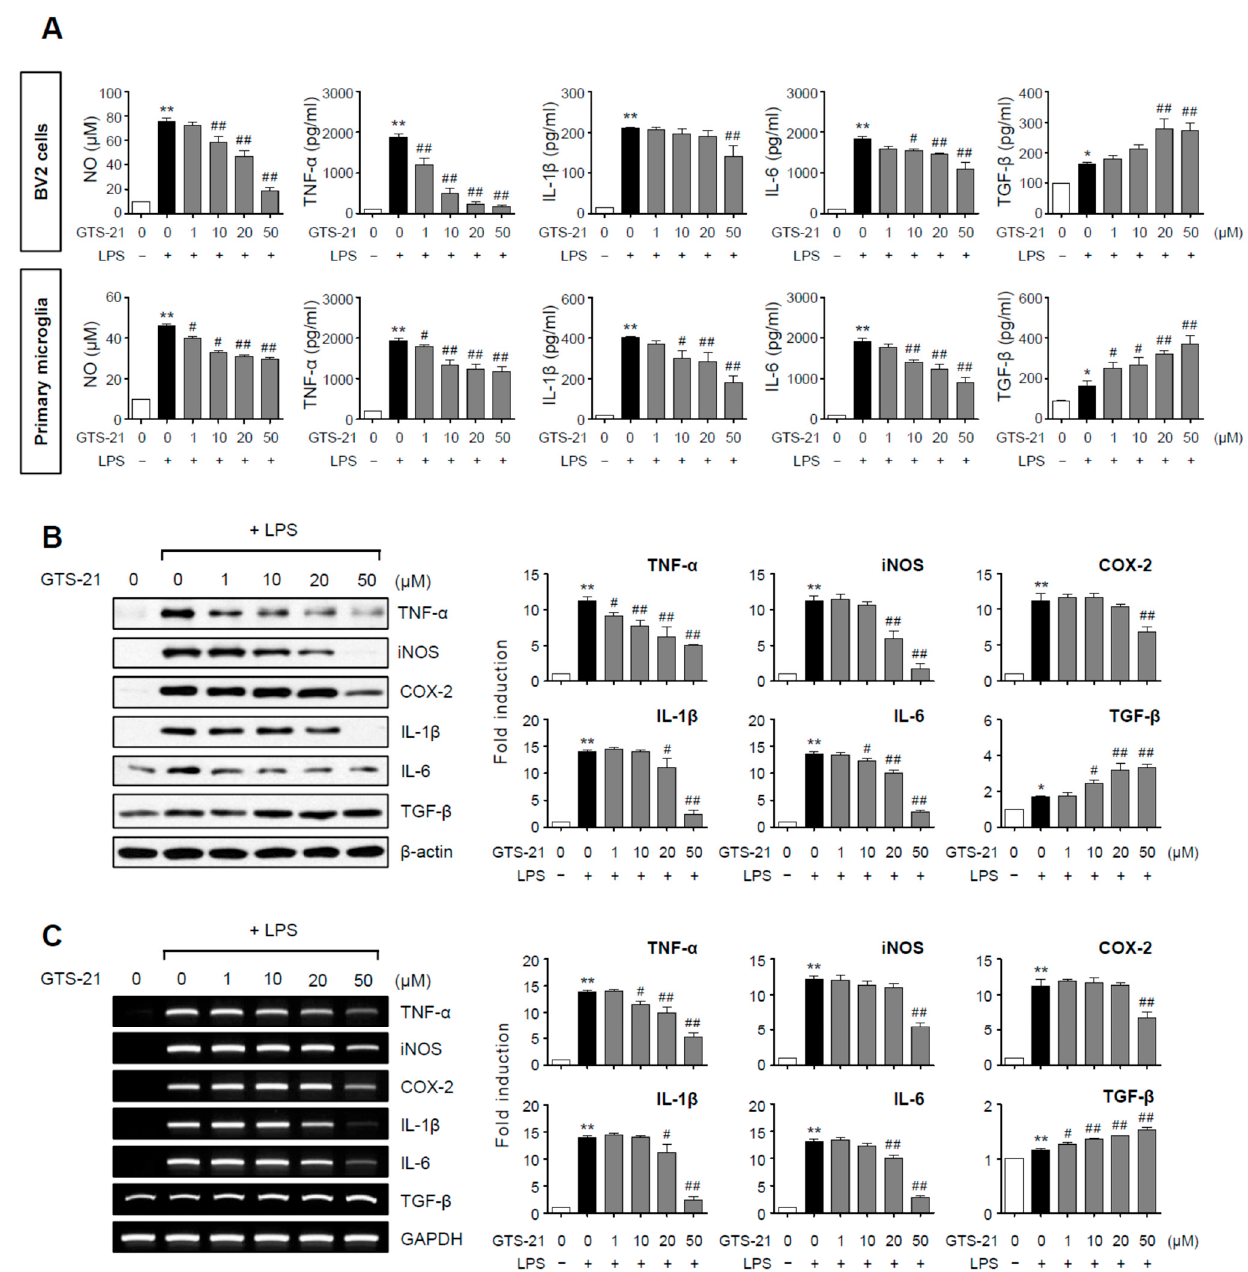
Figure 1. Effect of GTS-21 on inflammatory molecules in LPS-stimulated microglial cells. ( A ) After pretreatment with GTS-21 for 1 h, BV2 cells or primary cultured microglia were incubated with LPS (100 ng/mL for BV2, 10 ng/mL for primary microglia). The levels of nitrite, TNF- α , IL-1 β , IL-6, and TGF- β were assessed in supernatants after a 16 h incubation period ( n = 3–5 per group). ( B , C ) BV2 cells were treated with GTS-21 for 1 h before being incubated with LPS for 6 h. Western blot analysis ( B ) and RT-PCR ( C ) were performed to determine the expression level of inflammatory molecules ( n = 3–4 per group). The left panel shows representative blots/gels, whereas the right panel shows quantitative data. The data are presented as the mean ± SEM. * p < 0.05, vs. control group; ** p < 0.01, vs. control group; # p < 0.05 vs. LPS-treated group; ## p < 0.01 vs. LPS-treated group.